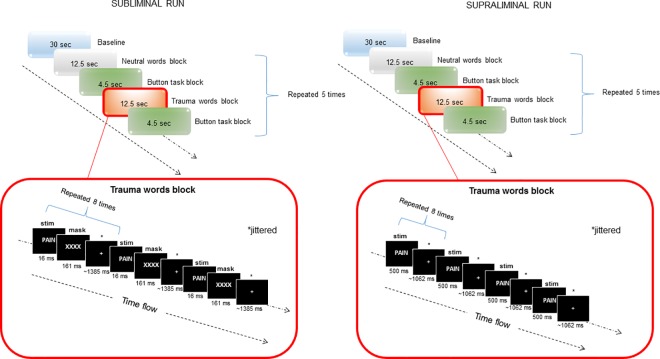
Graphical depiction of the experimental design.Subliminal session is depicted on the left, supraliminal session on the right. Above panels depict the block design. Below panels depict timing windows and stimulus presentation within word blocks (the trauma-related word block in this case). Note: ms: milliseconds; sec: seconds; stim: stimulus.